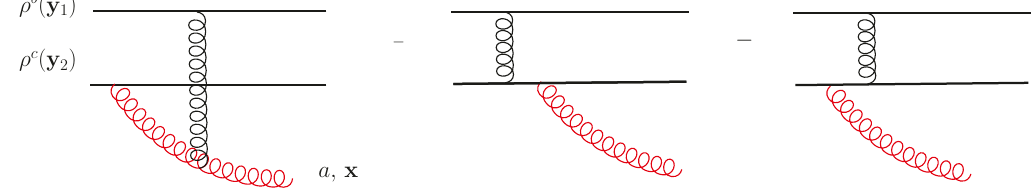
Figure 4 . The order- g classical gluon field α (1) ,a,i source at transverse position y .